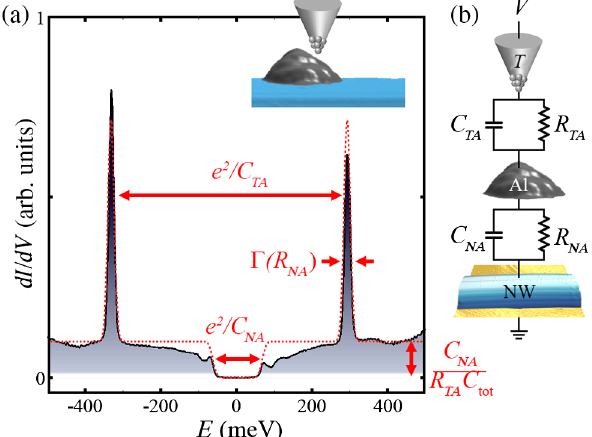
FIG. 3. (a) dI=dV at a particular position on the droplet [inset, indicated by arrow in Fig. 2(b)], with a fit to the simplified DBTJ model (red dashed line). The annotations refer to the circuit parameters that can be extracted from the measurement. (b) Sche- matic diagram of the equivalent circuit when the STM tip is positioned on the droplet that is deposited on the nanowire